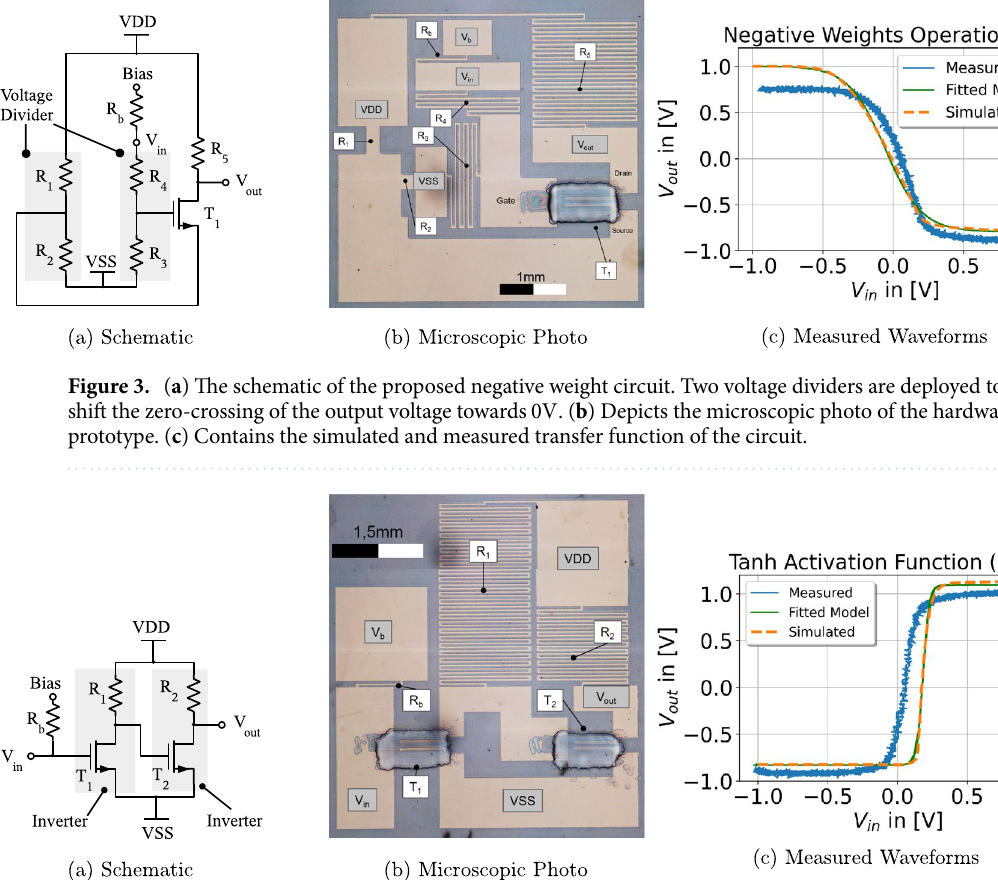
Figure 4. ( a ) Schematic of inverter-based activation function for realizing tanh function ( b ) depicts a microscopic photo of the fabricated hardware prototype of (ptanh) ( c ) contains the simulated and measured